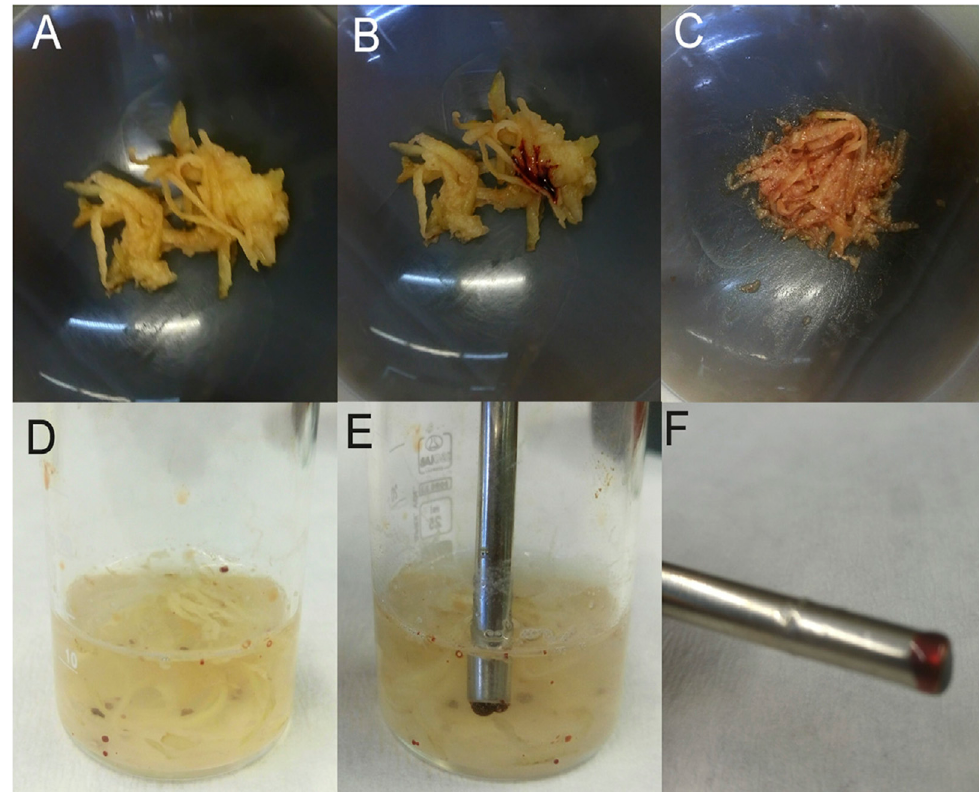
Figure 6. Representative pictures of the various steps of the developed procedure: ( A ) chopped potato in a mortar, ( B ) chopped potato with a drop of MIL before mixing, ( C ) chopped potato and MIL after mixing, ( D ) mixture of potato and MIL in saturated sodium chloride solution after ultrasonication, ( E ) harvesting the MIL droplets with a magnetic rod and ( F ) the collected MIL droplets on the magnetic rod. Reproduced with permission from [55]. Copyright Elsevier, 2018.